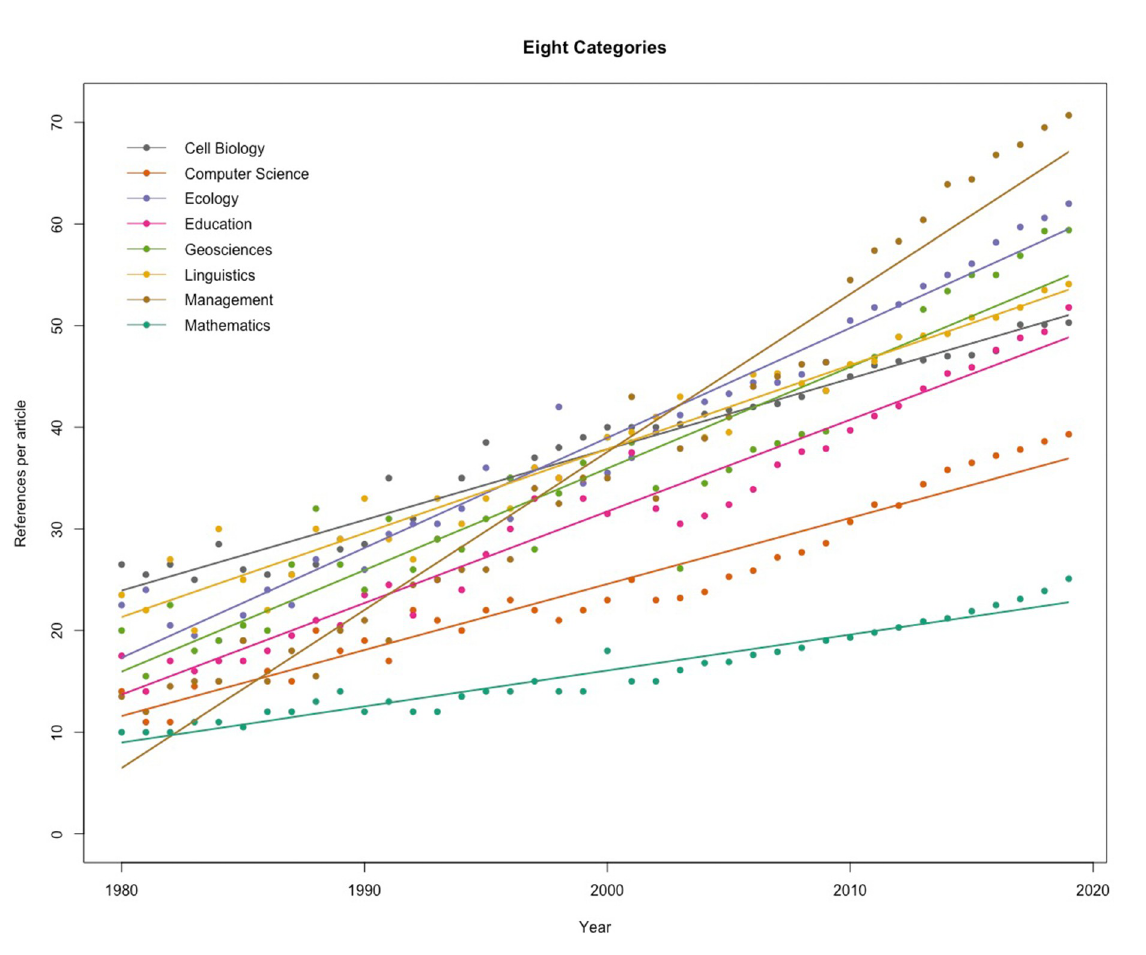
Fig 2. Linear trends in the number of references cited per research article from 1980 to 2019 in eight disciplinary categories.